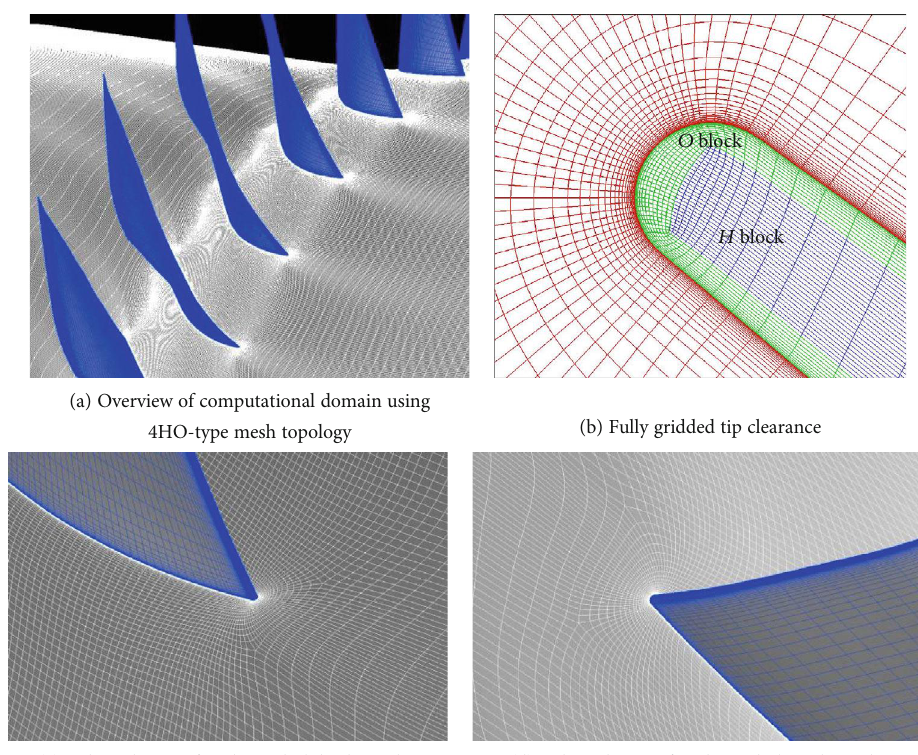
Figure 4: Computational grid of NASA Rotor